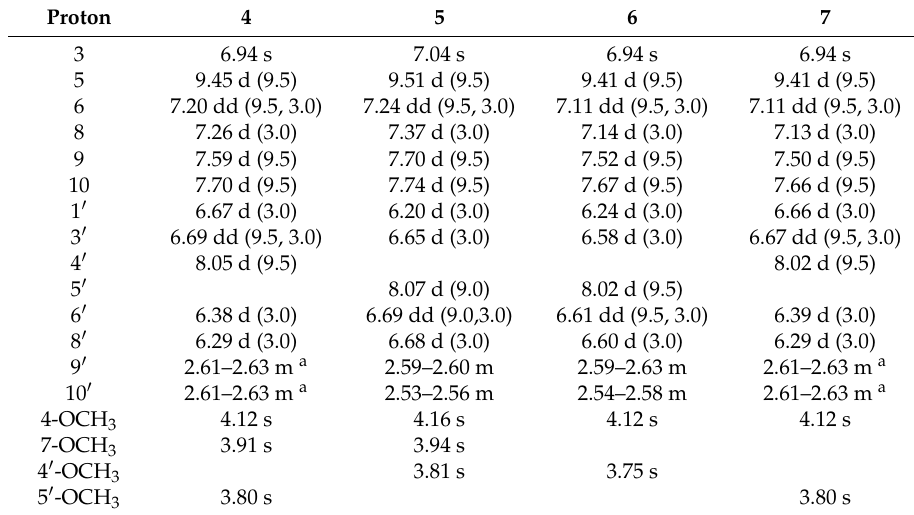
Table 3. 1 H-NMR Data of compounds 4 – 7